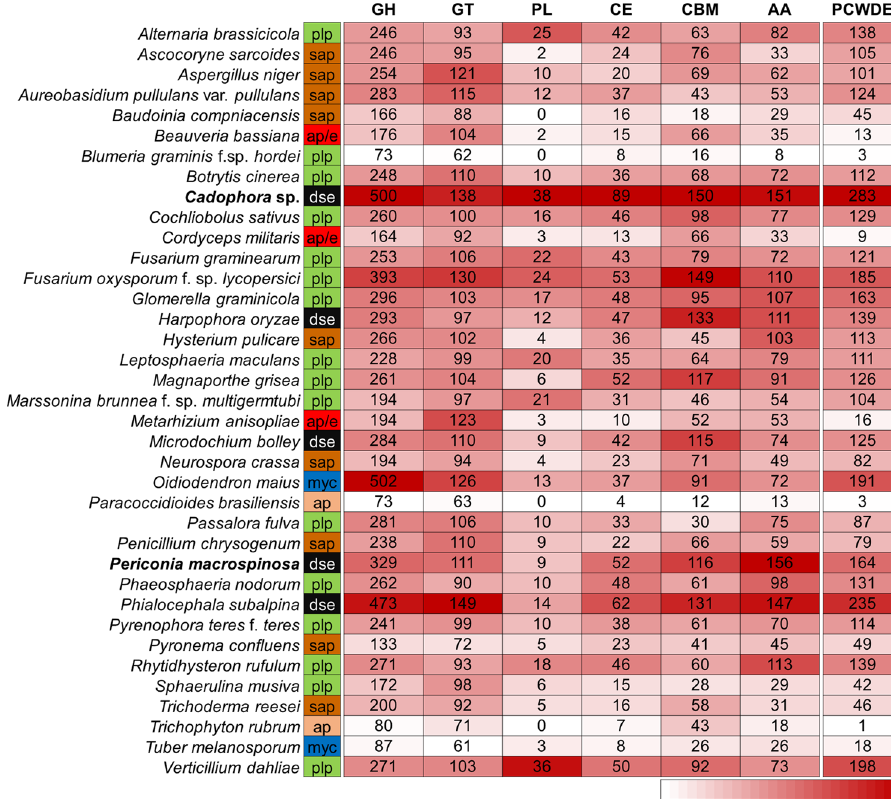
Figure 4. Number of genes encoding carbohydrate active enzymes (CAZymes) and plant cell wall degrading enzymes (PCWDE) in Cadophora sp., Periconia macrospinosa and other 35 fungi including three further DSE species. Major CAZyme classes are shown separately, including Glycoside Hydrolases (GH), Glycoside Transferases (GT), Polysaccharide Lyases (PL), Carbohydrate Esterases (CE), Carbohydrate-Binding Modules (CBM), and Auxiliary redox enzymes (AA). After each species name, its type of lifestyle is indicated as follows: red (ap/e; animal pathogens/endophytes), brown (sap; saprotrophs), green (plp; plant pathogens), black (dse, dark septate endophytes), blue (myc; mycorrhizal fungi), or pink (ap; animal pathogen). For each class of enzyme, white-to-red shading corresponds to lower to higher copy numbers. For detailed information on CAZymes copy numbers see Supplementary Table